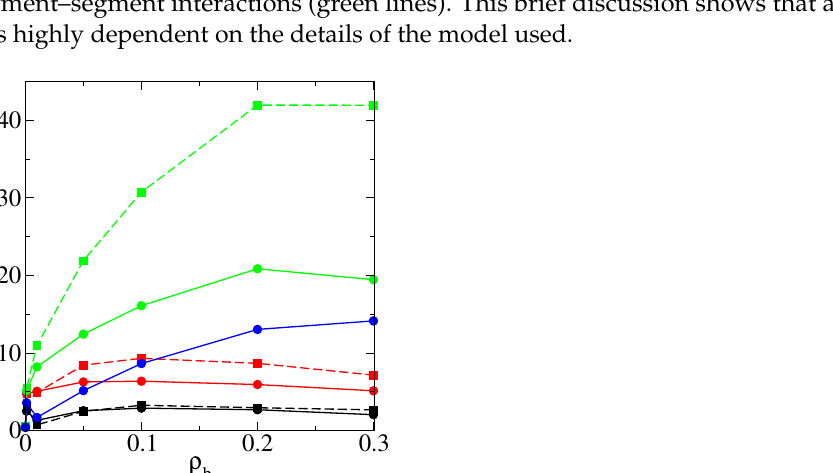
Figure 7. Excess adsorption isotherms on the particle with attached flexible (circles, solid lines) and rigid ligands (squares, dashed lines) for different models of adsorption: models M1 and M2 with ε = 1.5 ε (black), models M1 and M2 with ε = 3.0 ε (red), models M1a and M2a with ε = 3.0 ε (green), and model M1a with ε = 1.5 ε (blue). Other parameters: f = 20, M = 10. Symbols correspond to simulation points. Lines serve as a guide to the